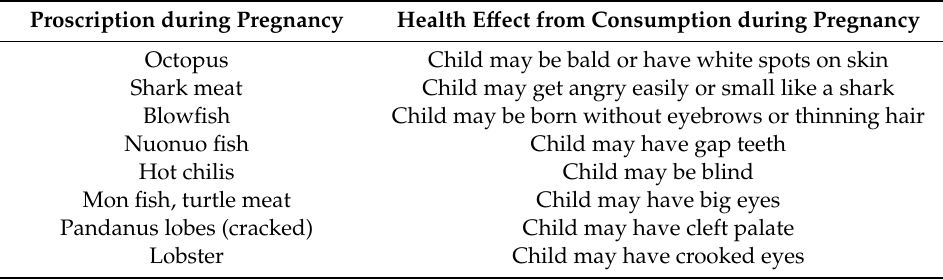
Table 6. Food proscriptions during pregnancy and possible birth outcomes for